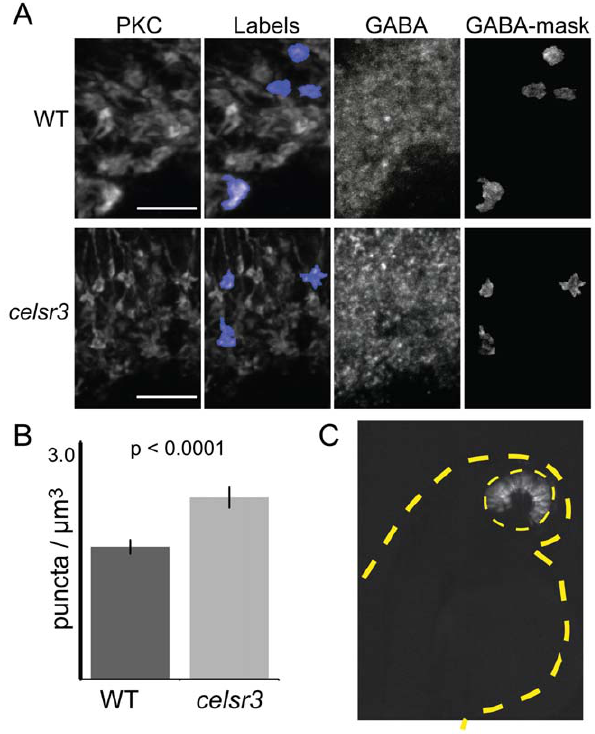
Figure 7. The number of GABA receptor puncta is increased on celsr3 mutant ON-bipolar terminals. A) ON-bipolar cells in cryosection were stained with anti-PKC antibodies and anti-GABA c 2. The PKC label fields were overlayed on the GABA signal, and the number of puncta was counted in each terminal rotated and visualized in 3D. Image shows merged z-stacks. Scale bars are 5 m m. B) The GABA puncta in the ON-bipolar terminals per m m 3 for WT and celsr3 mutants (n=60 terminals for each). Error bars are standard error. C) Mosaic 2 dpf larva containing WT cells in the eye (yellow dashed line) of a celsr3 mutant animal. Despite a large WT eye field transplant, this animal remained OKR negative. The tan dashed line outlines larva body.